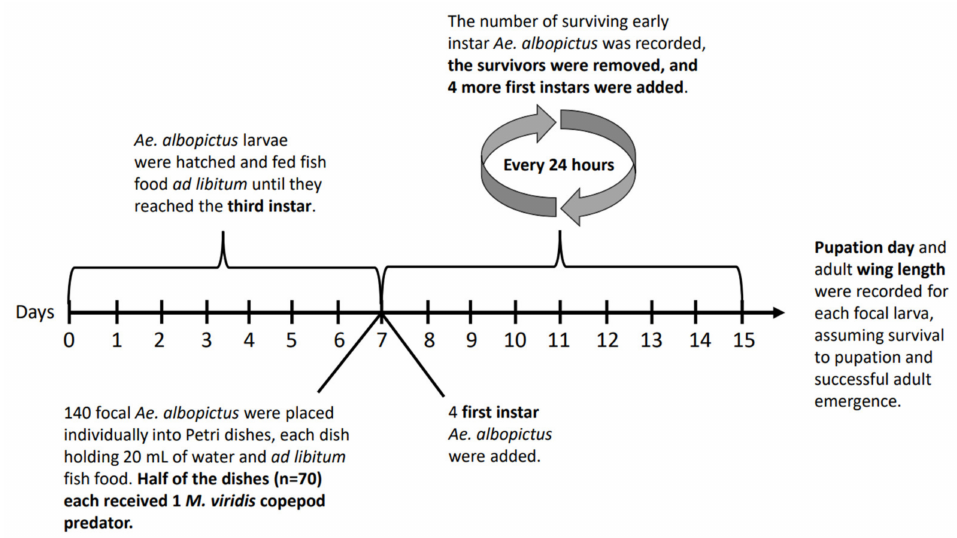
Figure 1. Experiment